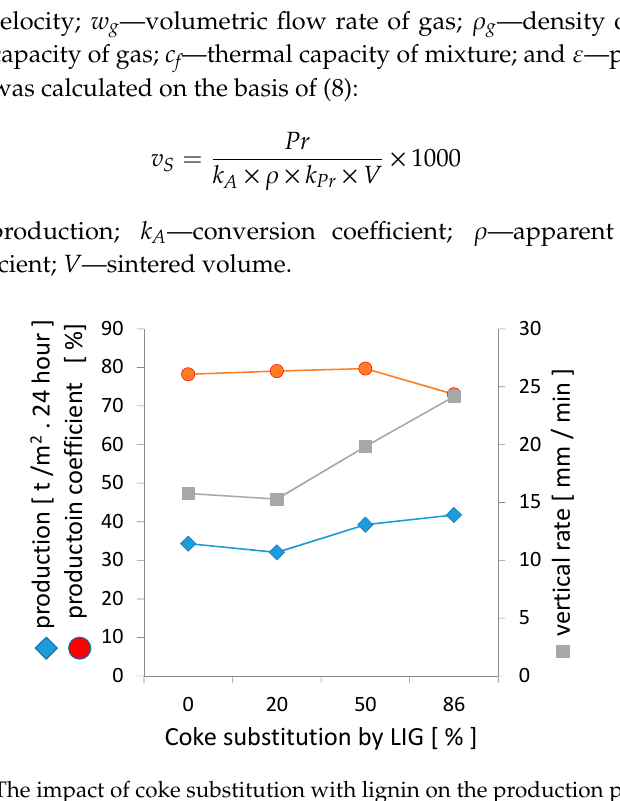
Figure 13. The impact of coke substitution with lignin on the production parameters.